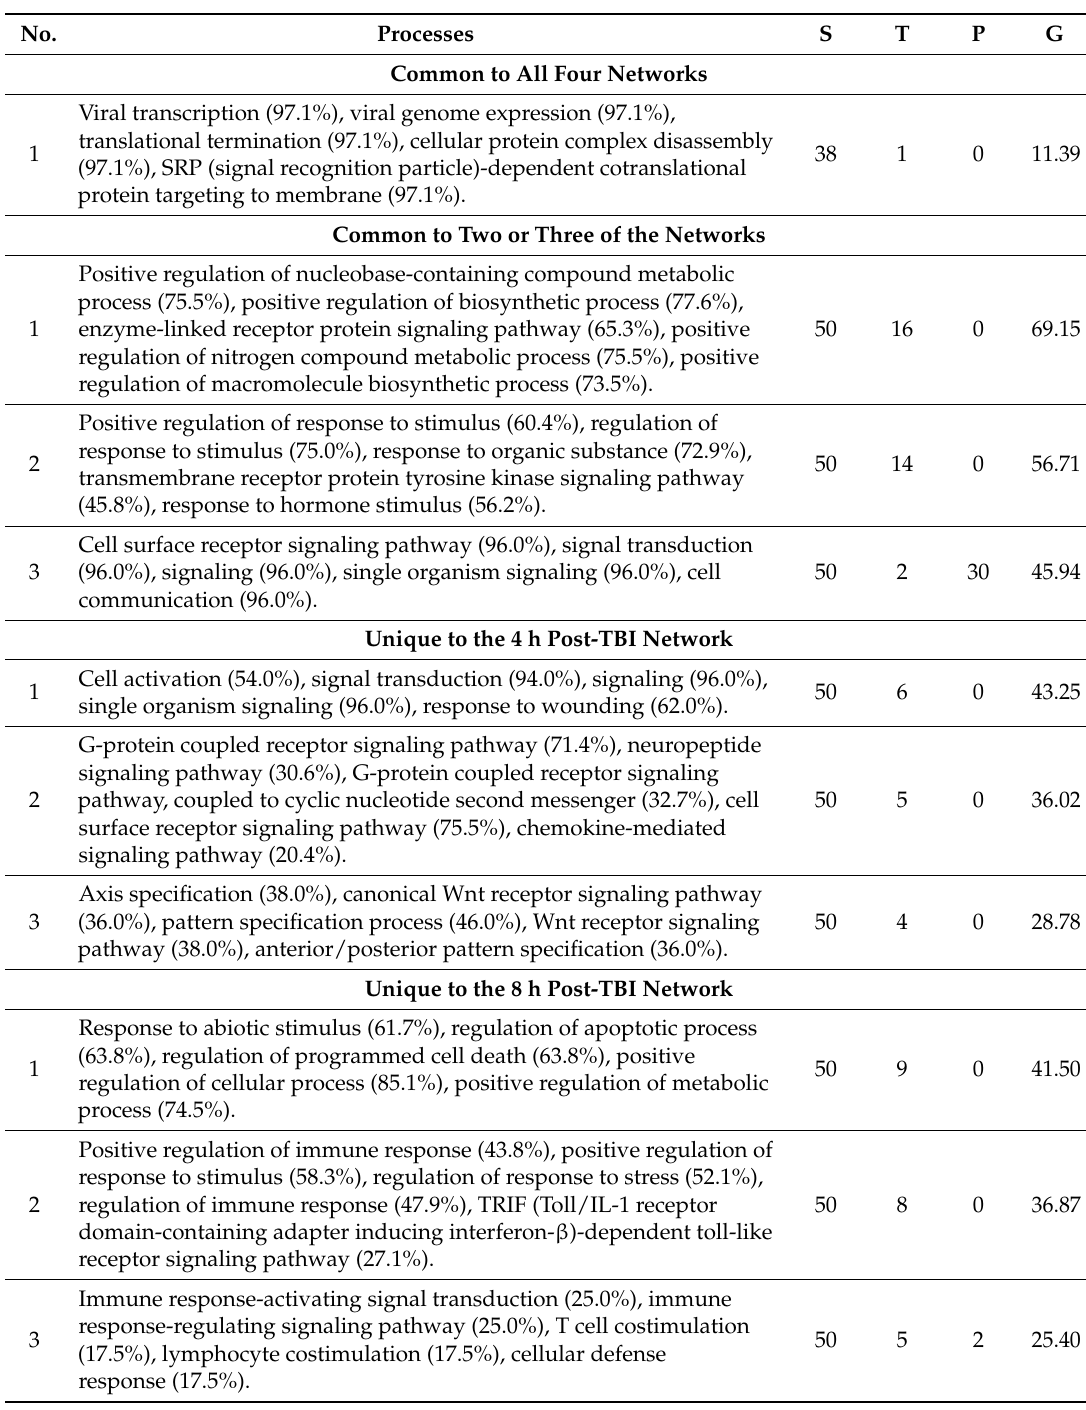
Table 3. Analysis of networks using MetaCore™. The gene content of the uploaded files was used as the input list for generating biological networks using the Analyze Networks (AN) algorithm with default settings. This is a variant of the shortest paths algorithm, with the following main parameters: (1) relative enrichment with the uploaded data and (2) relative saturation of networks with canonical pathways. These networks are built on the fly and are unique to the uploaded data. In this workflow, the networks are prioritized based on the number of fragments of canonical pathways in the